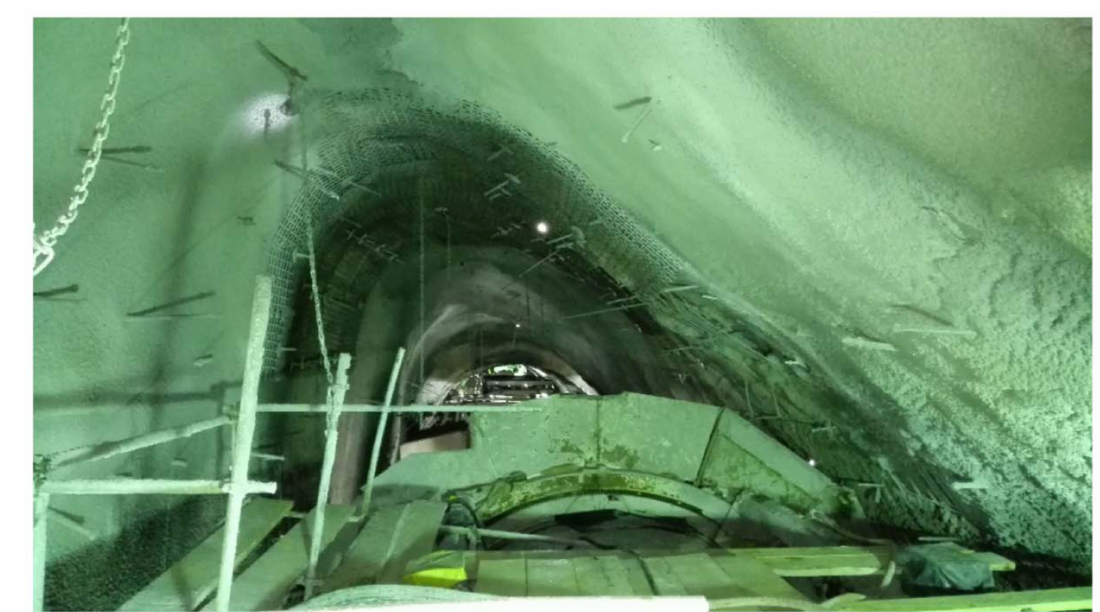
Figure 8. Over-excavation profile of the headrace tunnel after the rock burst on 31